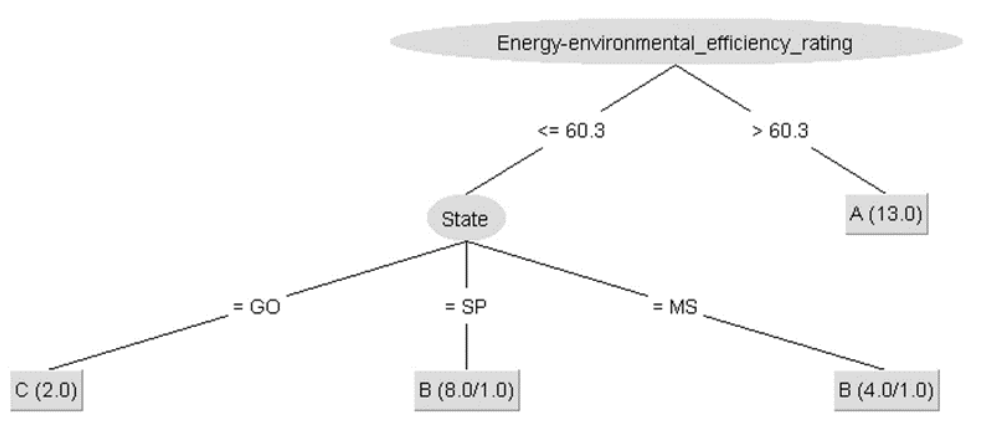
Figure 4. Decision tree for classifying the level of the energy-environmental e ffi ciency of